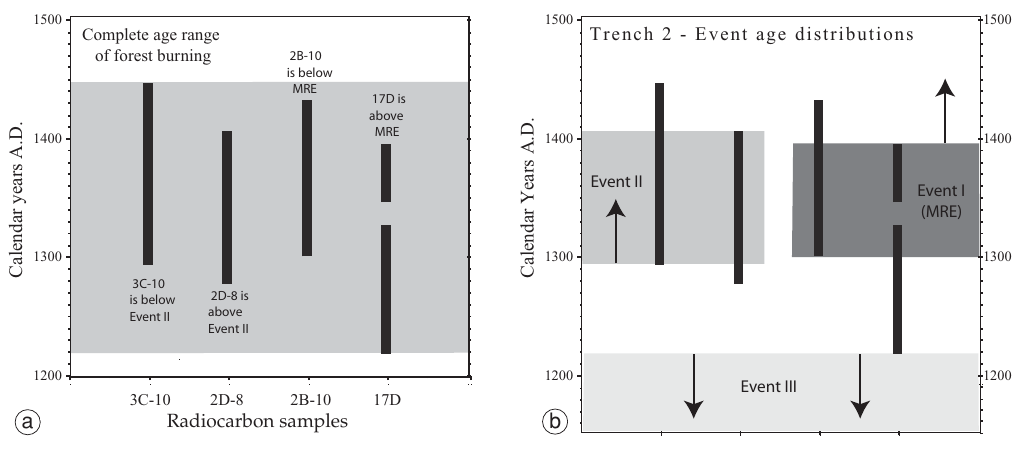
Fig. 11a,b. Two-sigma calibrated age ranges for the four young radiocarbon dates on charcoal from Trench 2 and their implications: a) the complete range of these samples represents wood probably burned in a sin- gle fire event; b) samples from above and below both Events I and II indicate that their event age distribu- tions are indistinguishable. Despite their overlap, these ranges can be used to define the likely bounds of Events II and